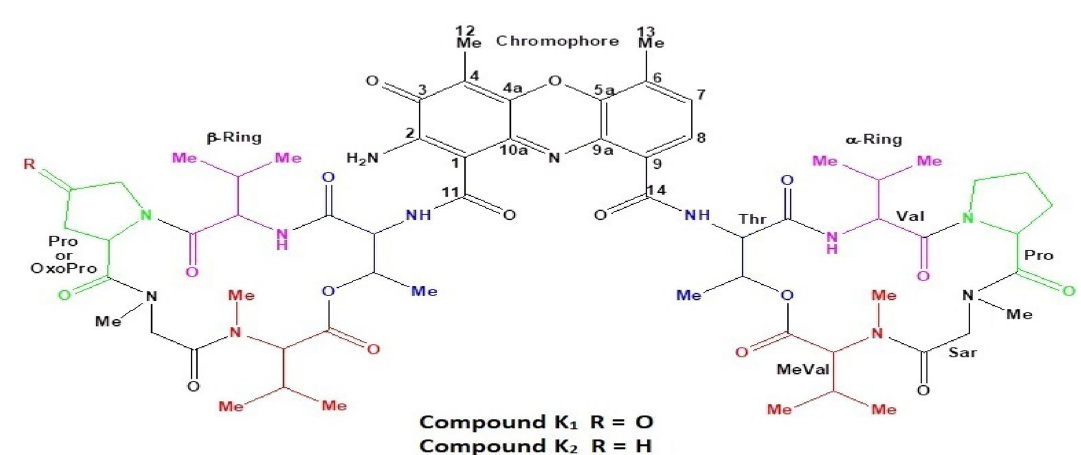
Figure 6. Predicted structure of isolated Actinomycin X 2 and Actinomycin D.